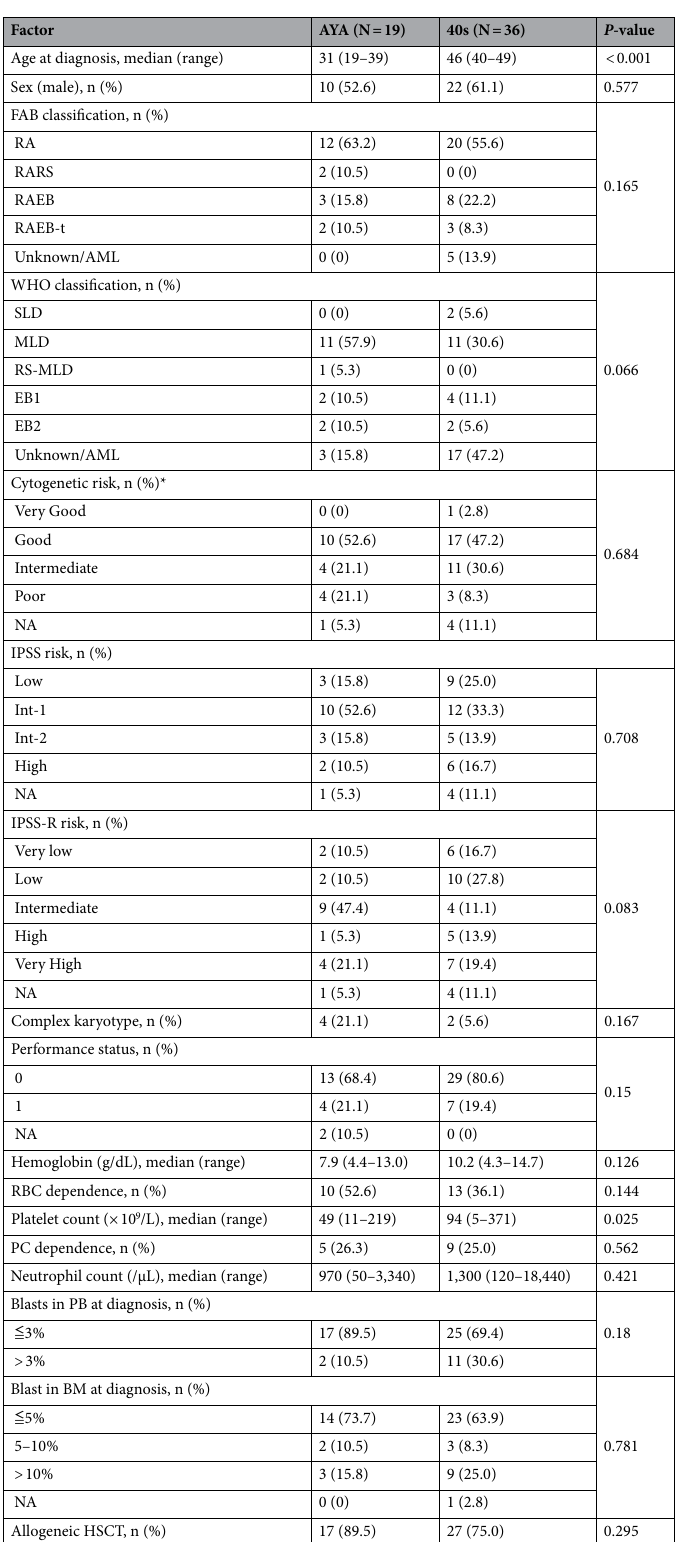
Table 1. Patient characteristics. AML acute myeloid leukemia, AYA adolescent and young adult, BM bone marrow, EB excess blasts, FAB French-American-British, HSCT hematopoietic stem cell transplantation, IPSS international prognostic scoring system, MLD multilineage dysplasia, NA not available, PB peripheral blood, PC platelet concentrate, RA refractory anemia, RAEB refractory anemia with excess blasts, RARS refractory anemia with ringed sideroblasts, RBC red blood cells, RS ringed sideroblasts, SLD single lineage dysplasia. *Cytogenetic risks were stratified based on the Revised International Prognostic Scoring System (IPSS-R) score 22